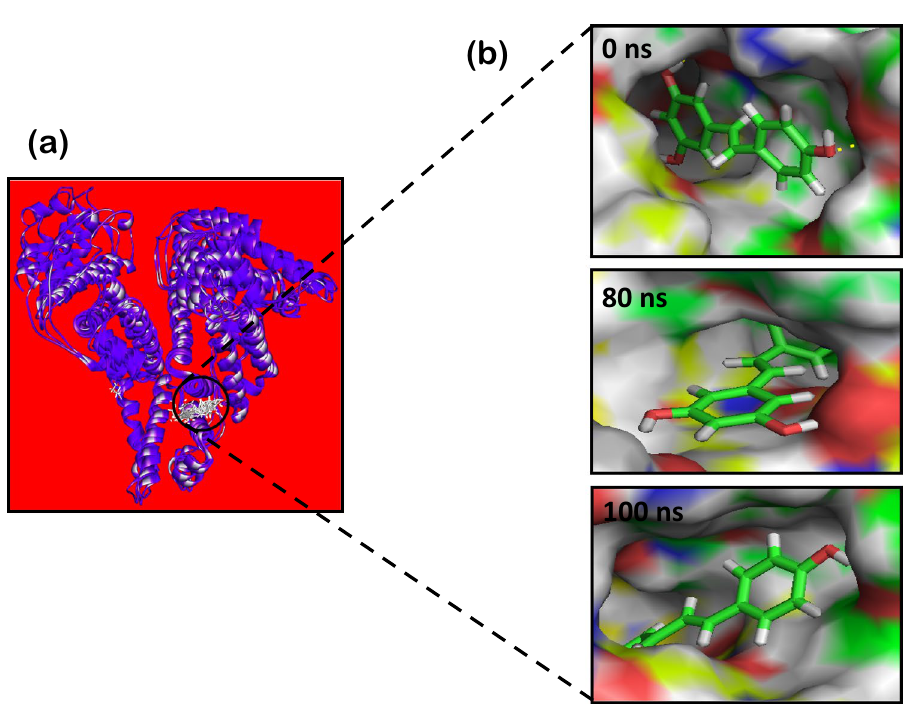
Figure 15. MD simulation results depicting (a) the cluster of trans -resveratrol molecule binding at subdomain IIA (Sudlow’s site 1) of HSA at 0, 80 and 100 ns, (b) surface view of the active site for the binding of trans- resveratrol to HSA obtained from MD simulation studies at 0, 80 and 100 ns simulation